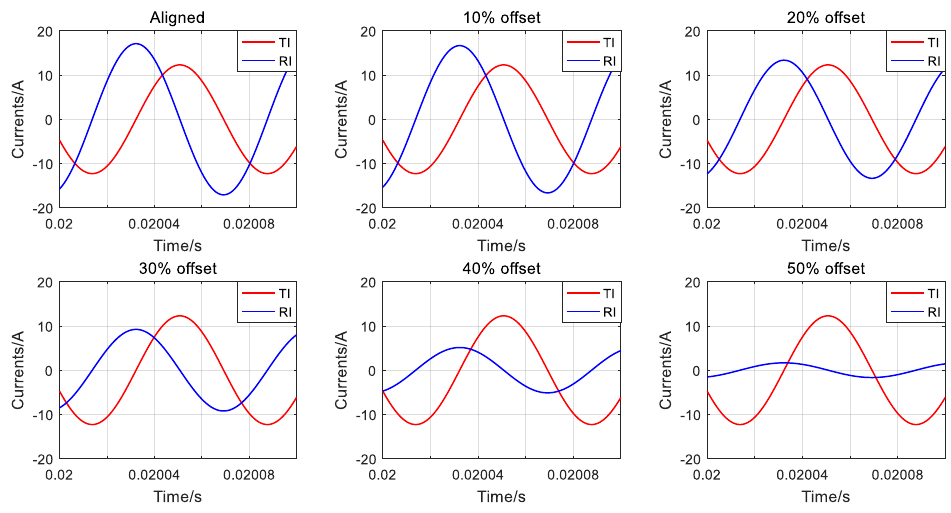
Figure 13. Currents of primary and secondary coils.